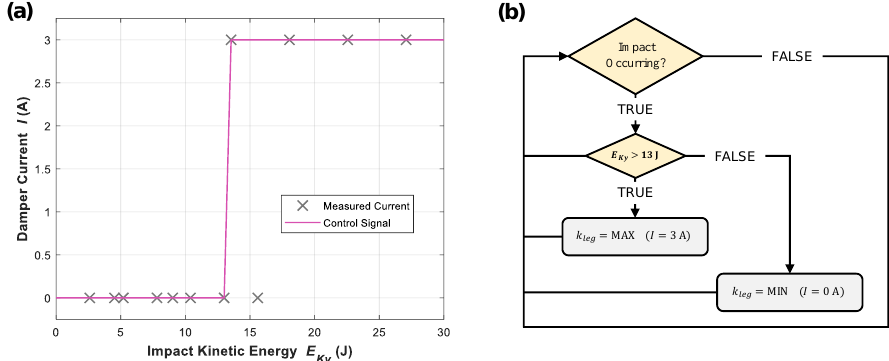
Figure 10. Impact force controller: ( a ) damper control signal, and ( b ) process flow diagram.